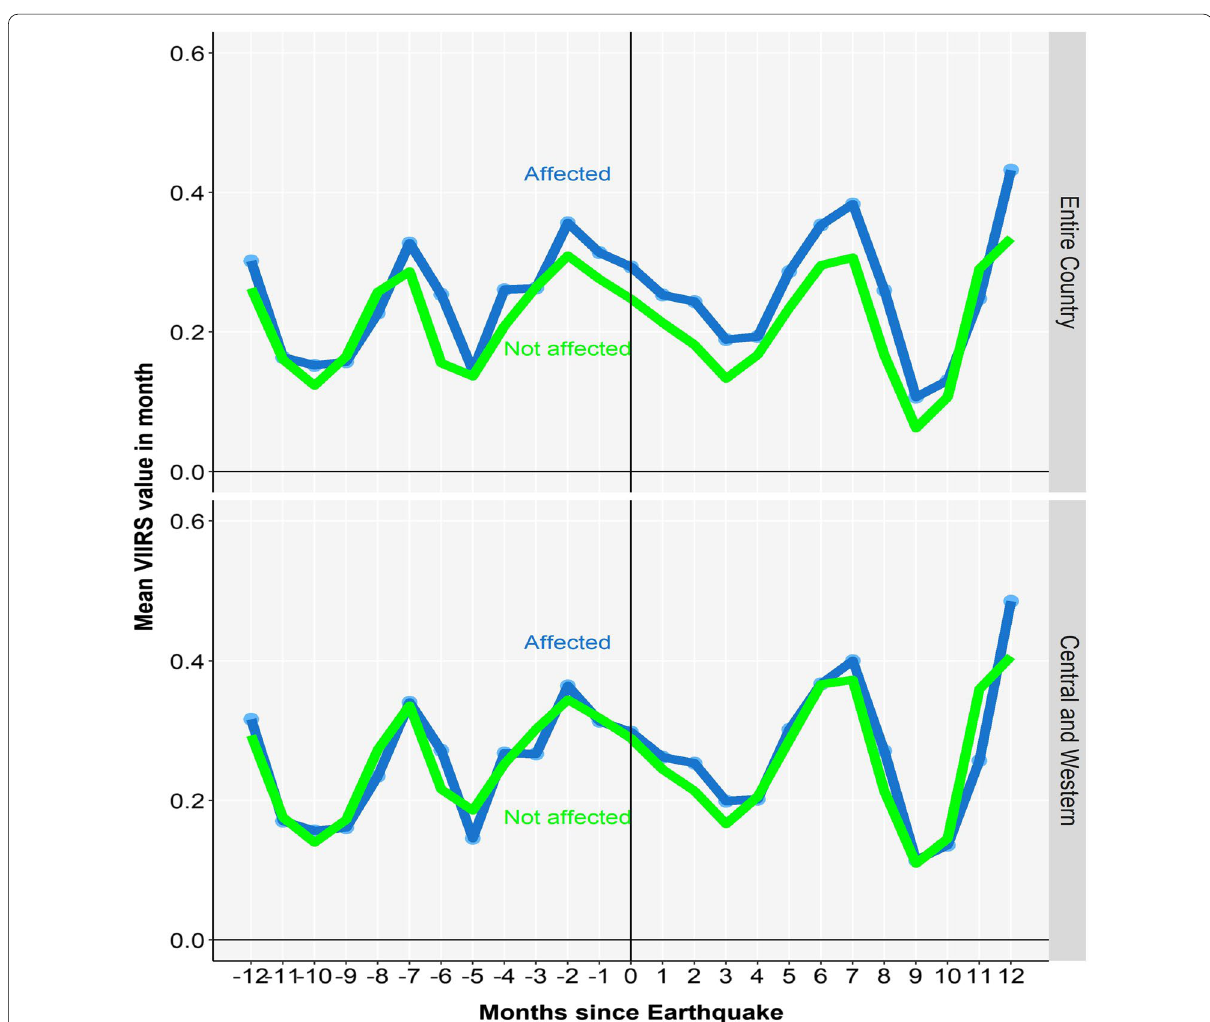
Fig. 6 Mean of nightlight cell values for Nepal and the Central and Western districts split between cells that were affected by earthquakes and those that were